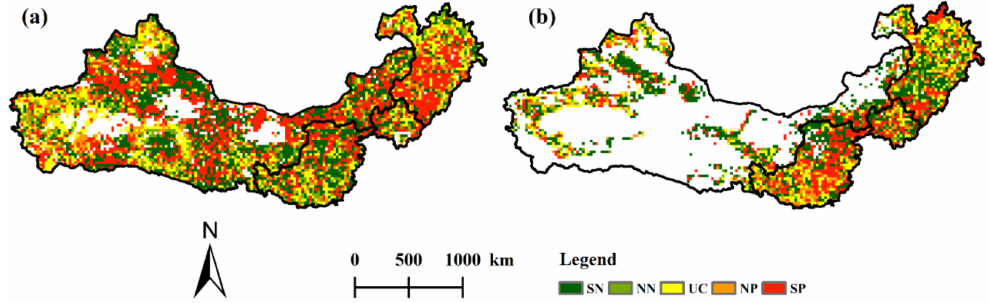
Figure 8. Spatiotemporal changes in ( a ) area proportion of grassland in 1 km × 1 km grid and ( b ) area proportion of cropland in 1 km × 1 km grid from 1981 to